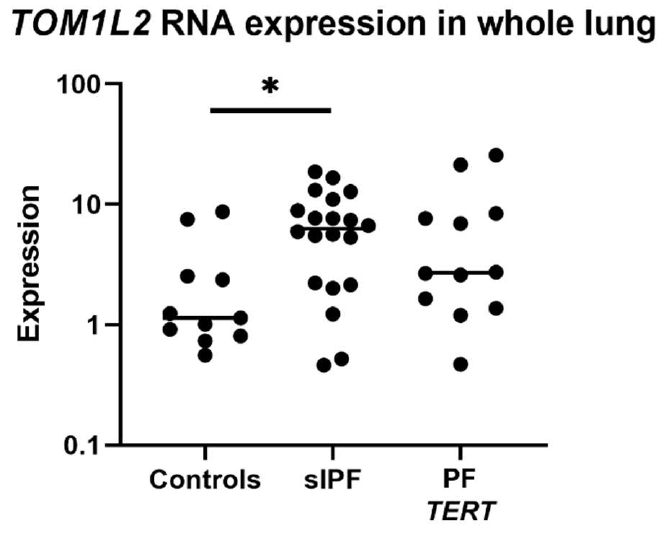
Figure 5. TOM1L2 RNA expression in whole lung tissue from controls, sporadic IPF patients (sIPF) and IPF patients with a TERT mutation (TERT). TOM1L2 expression is relative compared to the mean of three reference genes multiplied by 1000. * = p < 0.05.